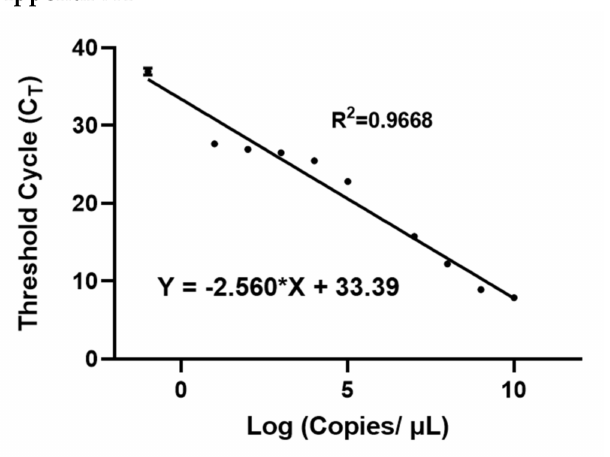
Figure A1. qPCR standard curve of Sec-miR. Different copy numbers of synthesized Sec-miR were spiked in 200 µ L culture medium. The Sec-miR-containing medium was further processed with an RNA isolation kit and subjected to qPCR assay to generate a qPCR standard curve of Sec-miR. The X-axis is shown as the log 10 of the copy number per µ L.